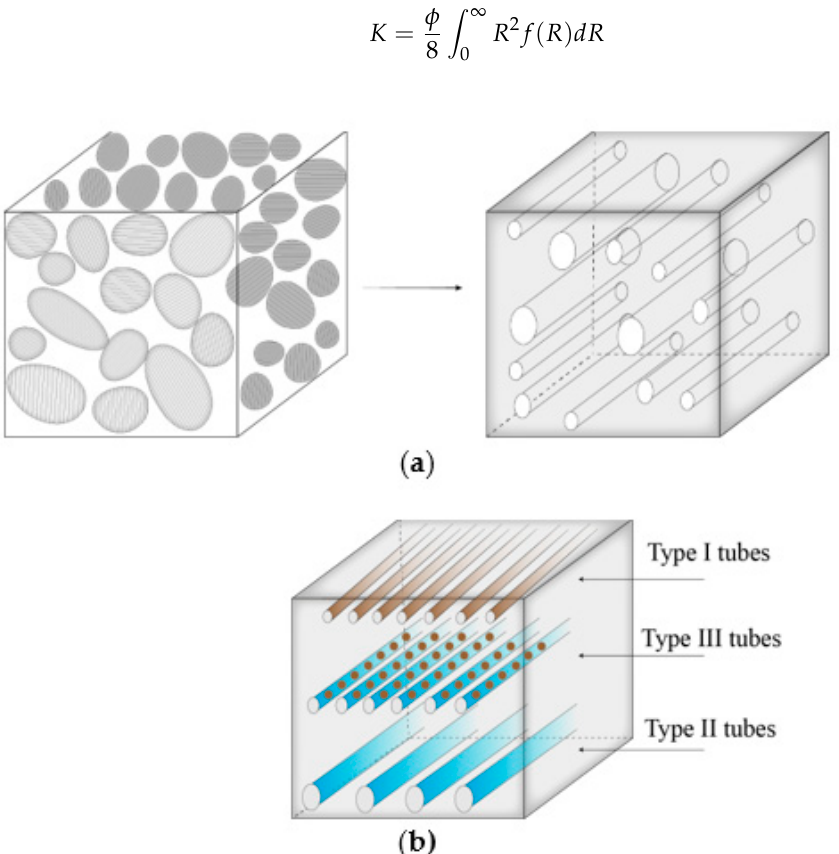
Figure 4. Schematic view of the porous medium and the proposed capillary bundle model. ( a ) Porous medium and capillary bundle model; ( b ) the way the capillary tubes divided into three types. By Darcy’s law of multiphase flow: